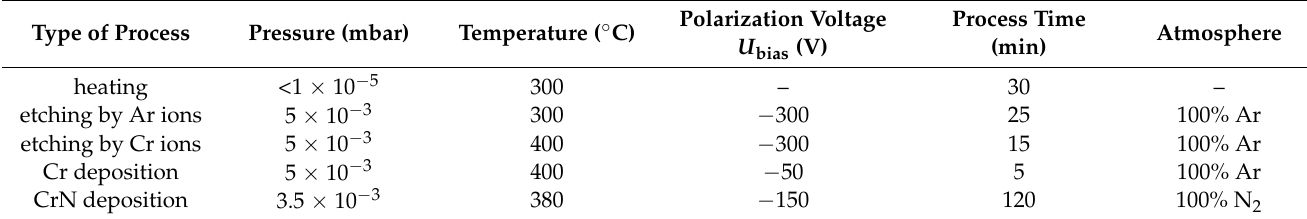
Table 2. Parameters of Cr/CrN metallic coating deposition